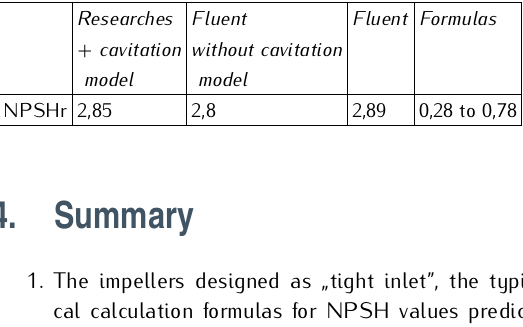
Table 4. NPSH values comparison (obtained by different